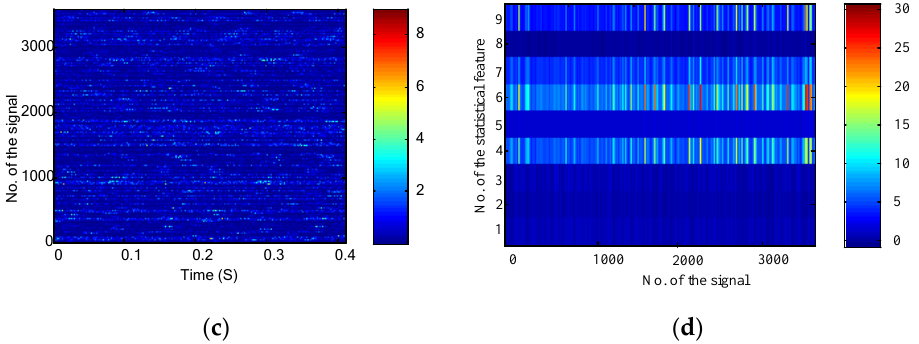
Figure 6. Time domain features for the gearbox fault diagnosis: ( a ) time domain waveform of the first signal; ( b ) time domain statistical features of the first signal; ( c ) time domain waveforms of the 3600 collected signals; and ( d ) time domain statistical features of the 3600 collected signals.